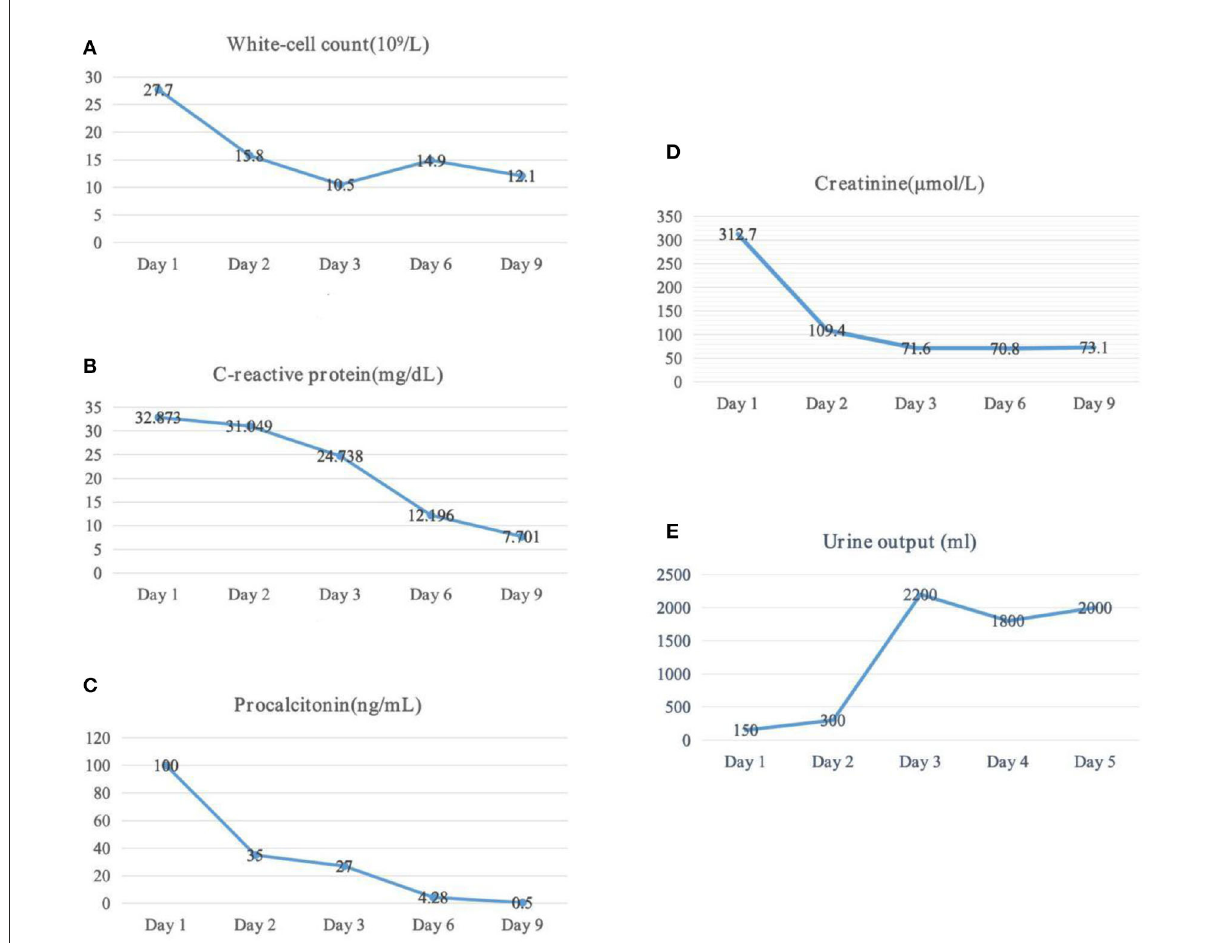
FIGURE2 Laboratory tests and urine output dynamic change. (A) Changes of white-cell, (B) changes of c-reactive protein, (C) changes of procalcitonin, (D) changes of serum creatinine, and (E) changes of urine